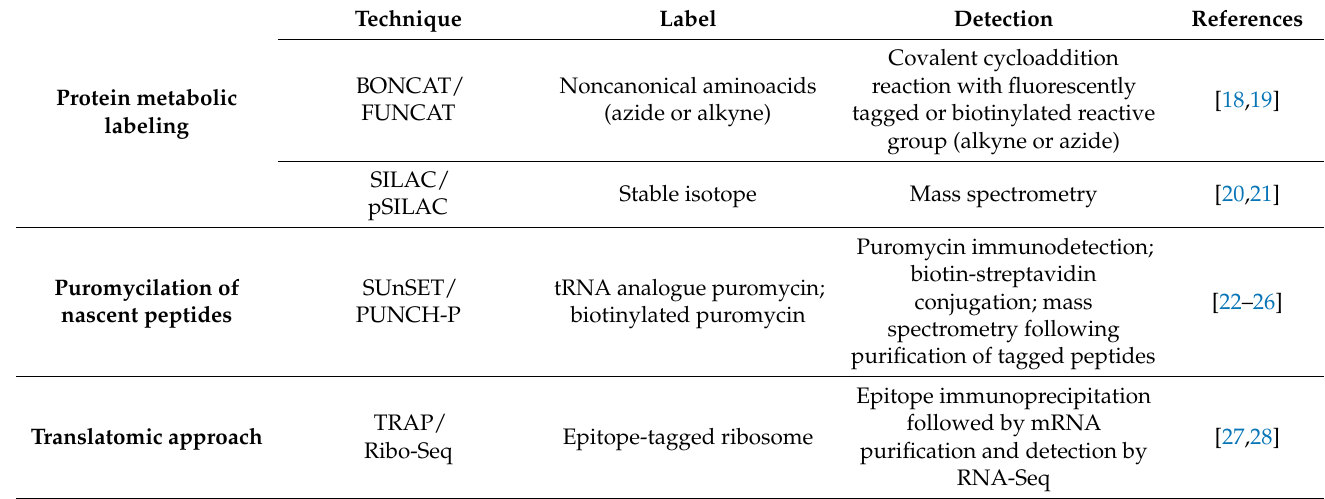
Table 1. Techniques utilized to measure de novo protein synthesis in neurites.